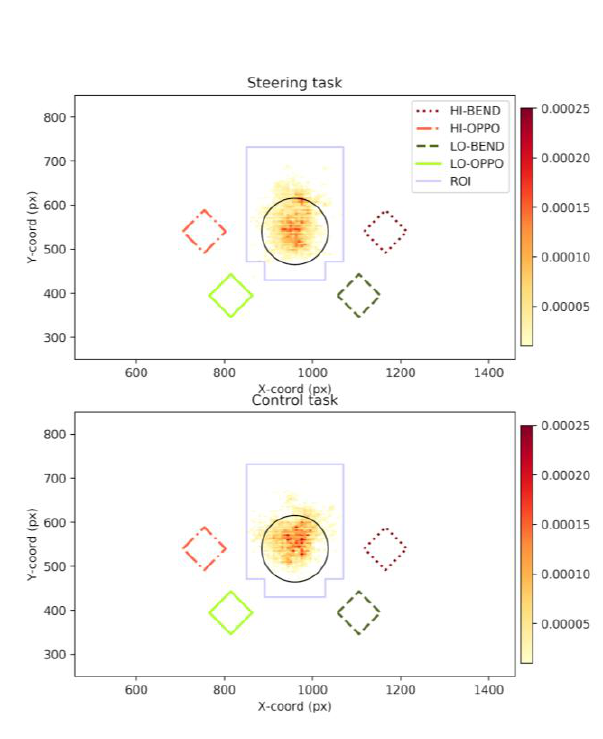
Figure 5. Top. The distribution of gaze points in relation to the fixation circle and the different target locations during target presentations that were accepted into the analysis in the steering task. If a single gaze point during a target/distractor presentation was outside of the blue region of interest (ROI), the presentation was excluded from the analysis . Bottom. Otherwise the same distribution, but for the control